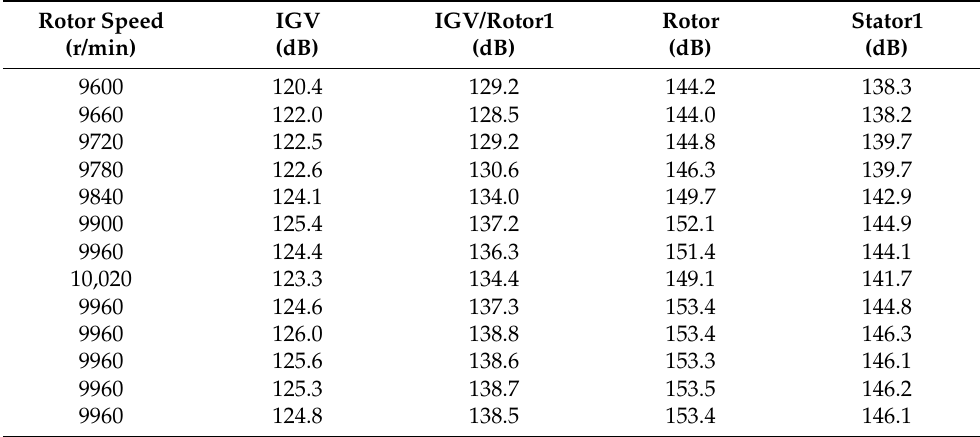
Table 1. Distribution of sound pressure level at 1402 Hz of noise signals at different measurement